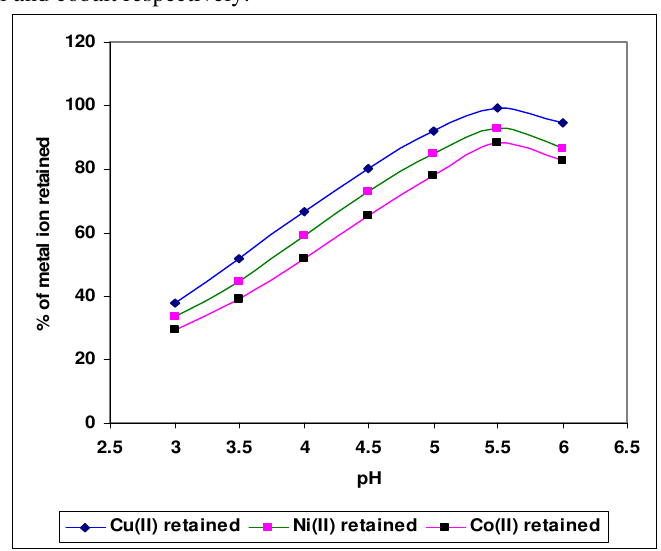
Figure 2 . Chemisorption of metal ions by P- DTA versus pH